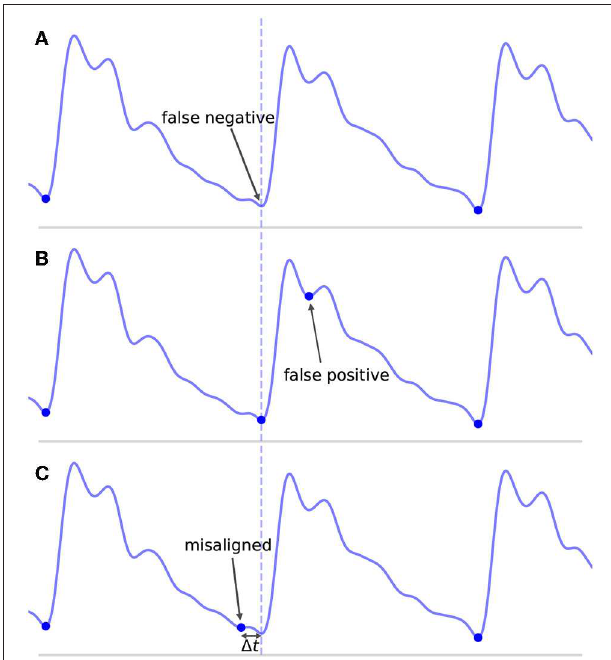
FIGURE 6 | Shown are the different types of classification errors. These are shown for illustrative purposes and are not actual output of the algorithm. The dotted vertical line indicates the correct position of the beat onset. (A) Shows the typical situation in which a false negative arises: the algorithm fails to mark an onset for an obvious beat in between two neighboring detected beats. (B) Shows an example of a false positive, in which an extra onset unassociated with any true onset has been detected. (C) Illustrates a misaligned beat in which a true onset has been found, but its placement is offset from the true location.